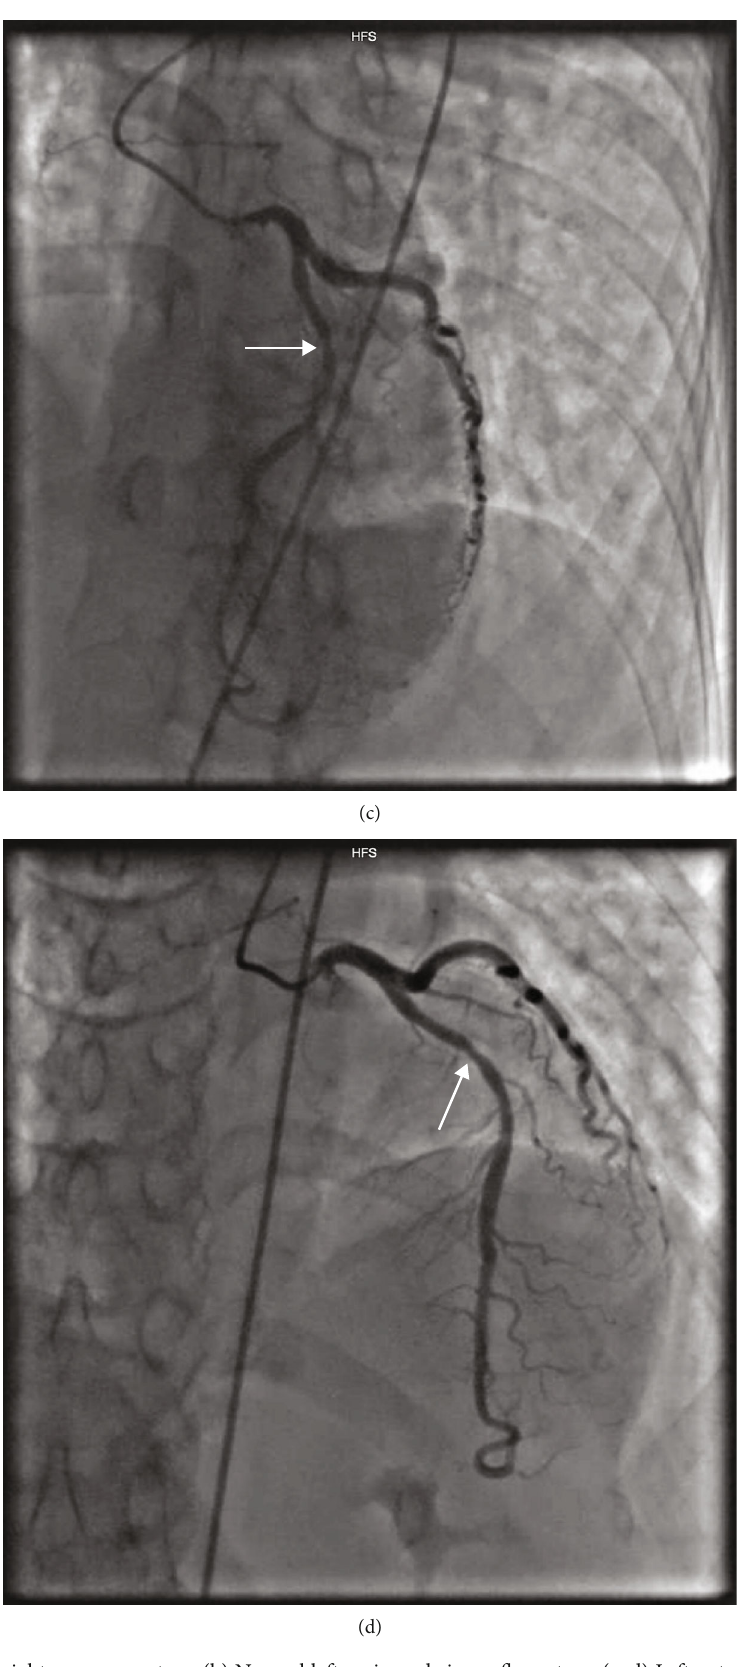
Figure 2: (a) Normal right coronary artery. (b) Normal left main and circum fl ex artery. (c, d) Left anterior descending